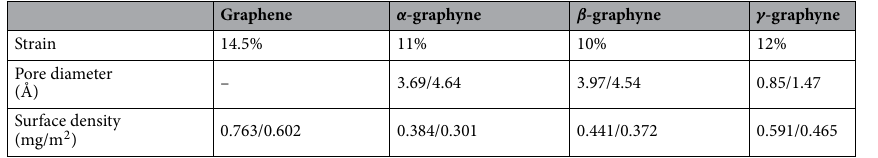
Table 2. Pore diameters and mass surface densities for the investigated monolayers before and after the introduction of strain. The strain value indicated in the first row corresponds to the deformation used in the GCMC simulations. The first/second number on each column corresponds to the structure without/with strain.We did not provide a pore diameter for graphene because it is a non-porous material.